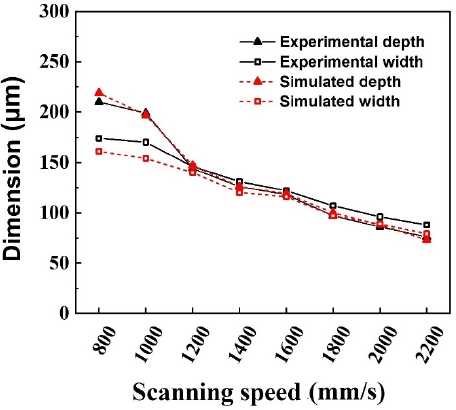
Figure 4. Melt pool morphology of different scanning speeds at a laser power of 400 W: ( a – d , i – l ) simulated ; ( e – h , m – p ) experimental.